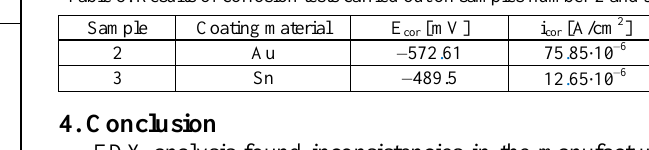
Table 4. Surface roughness values Sample